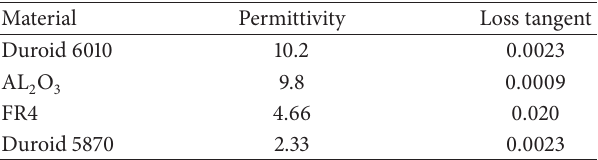
Table 1: Dielectric properties of different substrate materials. Material